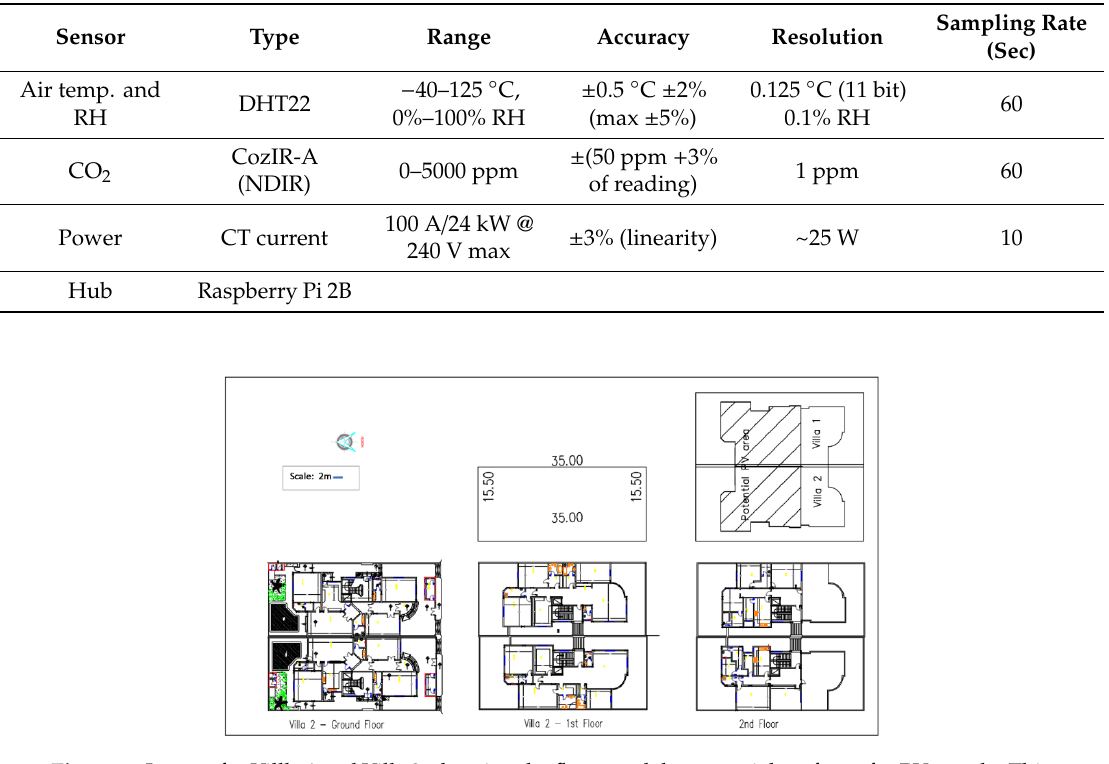
Figure 6. Layout for Villla 1 and Villa 2, showing the floors and the potential roof area for PV panels.